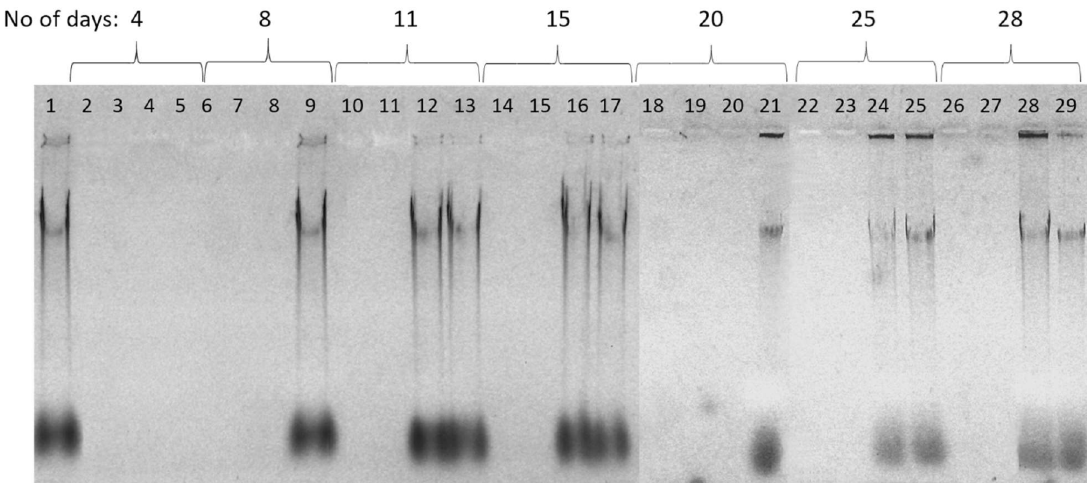
Figure 10. Plastic surface treated with PHMG-Cl inactivates eDNA. Shown here is a 1.2% agarose-TA gel stained with EtBr to visualize eDNA recovered from plastic treated with PHMG-Cl for up to 28 days. PHMG-Cl treatments (1%, 0.5%, 0.1%, and 0.05% are grouped according to the length of exposure (days). Treatments: (1) clean-surface control, (2, 6, 10, 14, 18, 22, and 26) 1% PHMG-Cl, (3, 7, 11, 15, 19, 23, and 27) 0.5% PHMG-Cl, (4, 8, 12, 16, 20, 24, and 28) 0.1% PHMG-Cl, and (5, 9, 13, 17, 21, 25, and 29) 0.05%